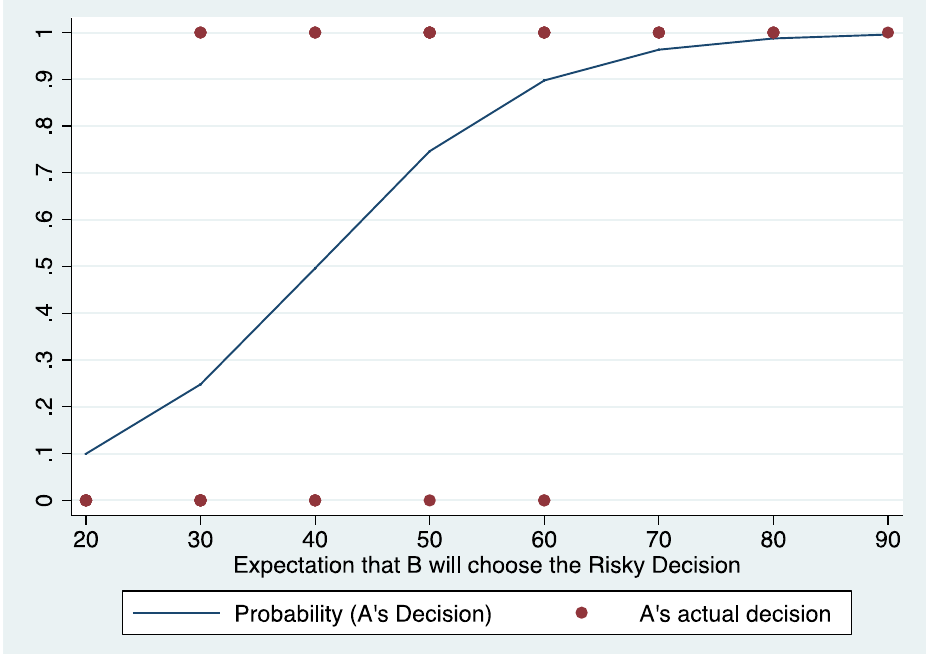
Figure 2. Predicted probabilities of Player A’s decision and observed values, after conducting a logistic regression using A’s decision as the outcome and A’s expectations as the predictor.